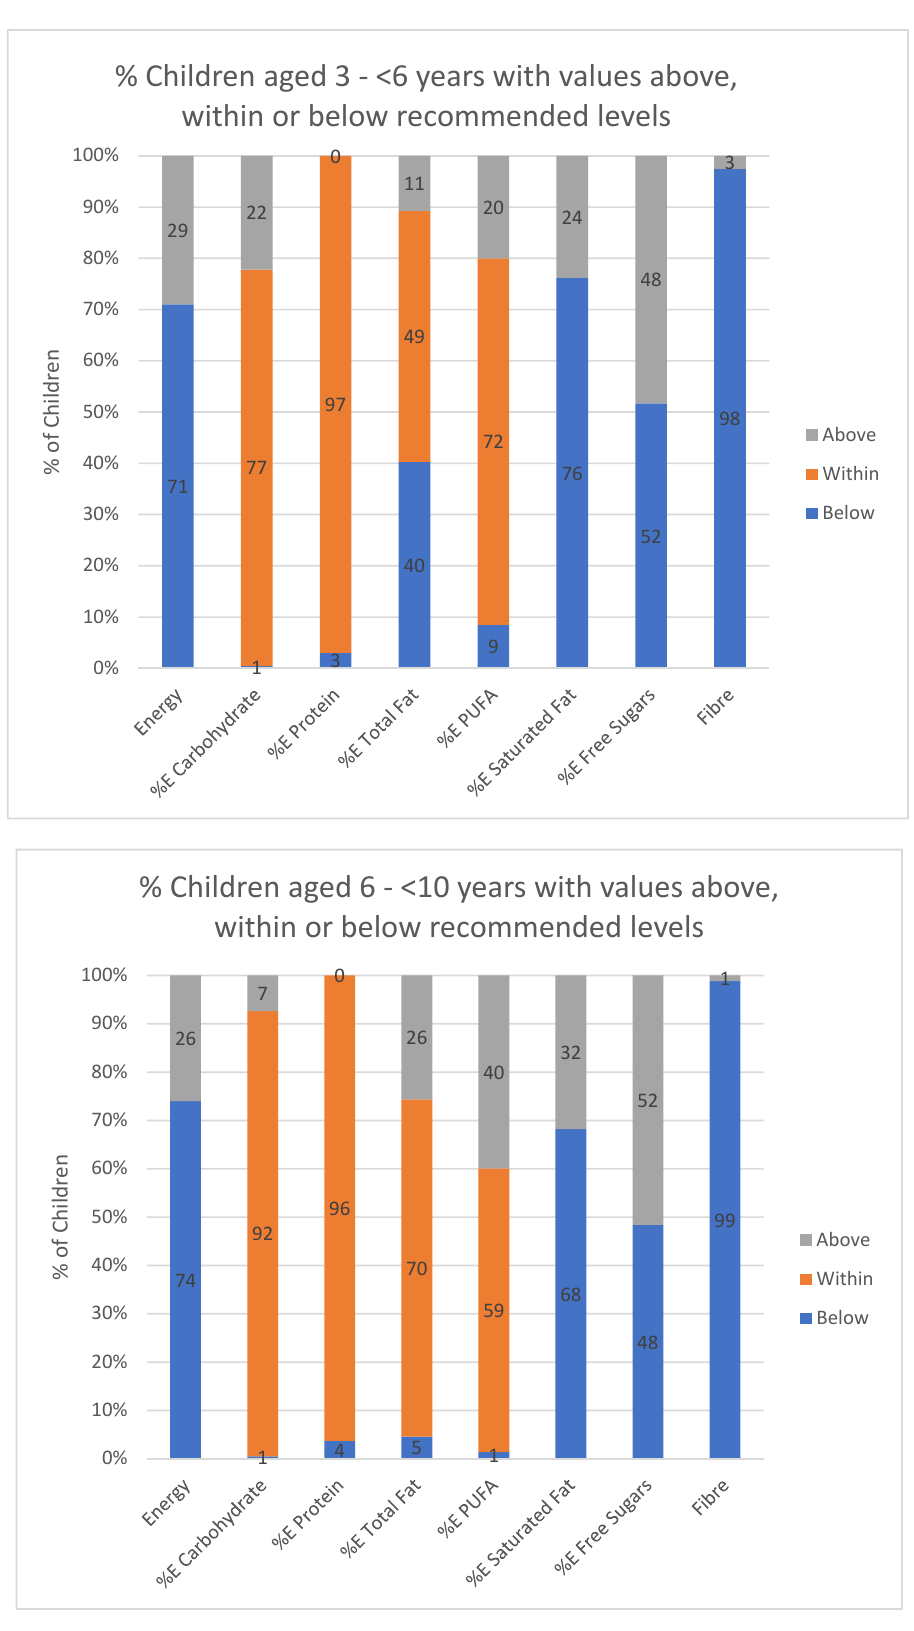
Figure 2. Children aged 1– < 3 years; 3– < 6 years and 6– < 10 years, lying below, within, or above recommended energy and macronutrient intake ranges for their age. EER = Estimated energy requirement (37]: M (1–2 yrs): 4393 kJ; F (1–2 yrs): 4166 kJ; M (3 yrs): 6213 kJ; F (3 yrs): 5837 kJ; (4